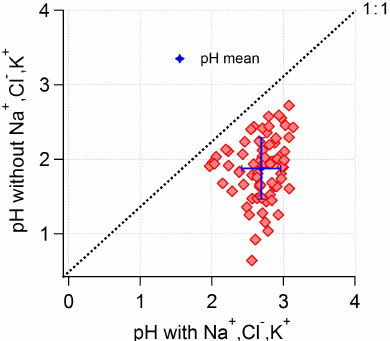
Figure 3. Comparison of predicted PM 2 . 5 particle pH assum- ing external versus internal mixing of Na + , Cl − , and K + with SO 2 − , NO − , and NH + for data from the last week of the CalNex 4 3 4 study (i.e., SO 2 − –NO − –NH + –HNO 3 –NH 3 system vs. SO 2 − 4 3 4 NO − –NH + –Na + –Cl − –K + –HNO 3 –NH 3 –HCl system). For these 3 4 two cases, pH increased from 1.9 ± 0.4 to 2.7 ± 0.3 with the input of Na + , Cl − , and K + . Figures 4 and 5 show that for PM 2 . 5 , inclu- sion of Na + , Cl − , and K + provides better predicted portioning of nitric